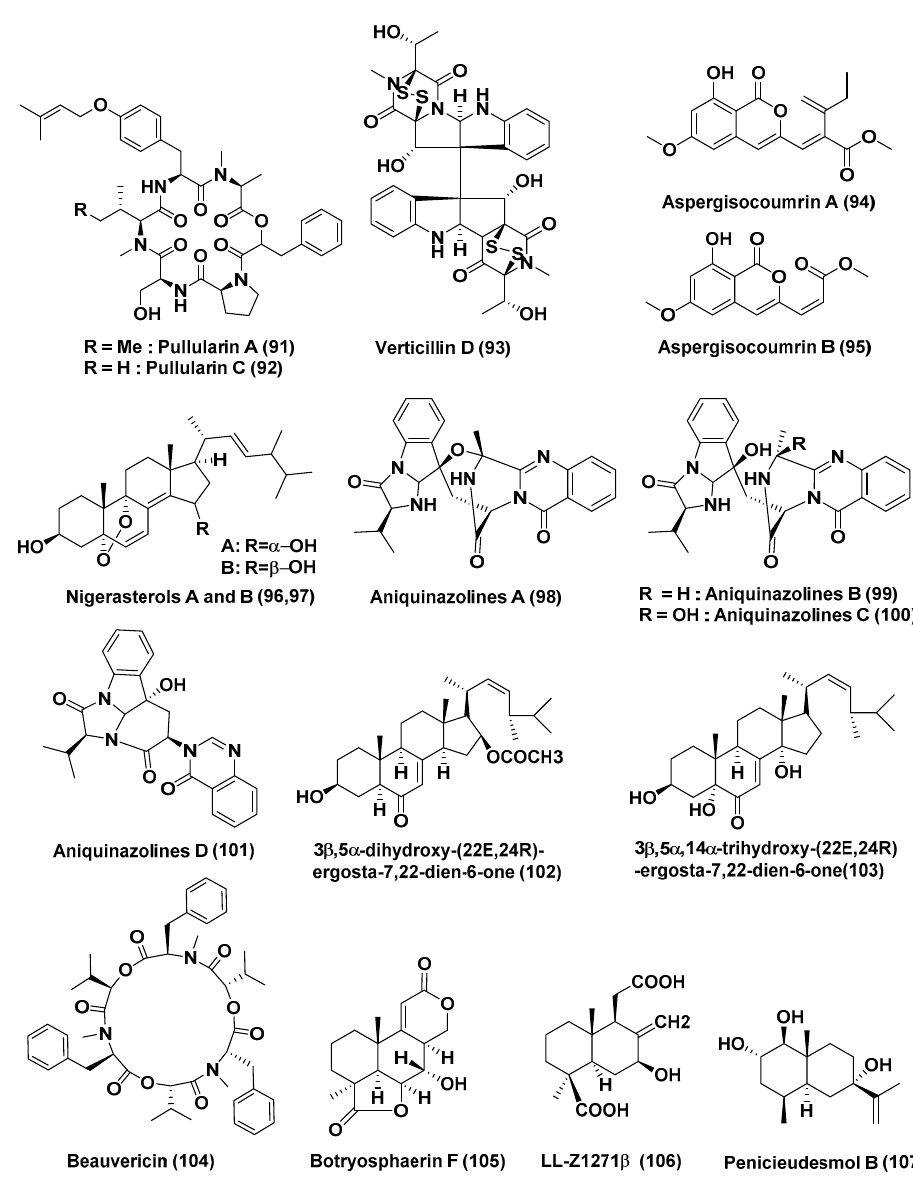
Figure 6. Structures of metabolites isolated from Ascomycetes ( 91 – 93 ) and Hyphomycetes ( 94 – 107